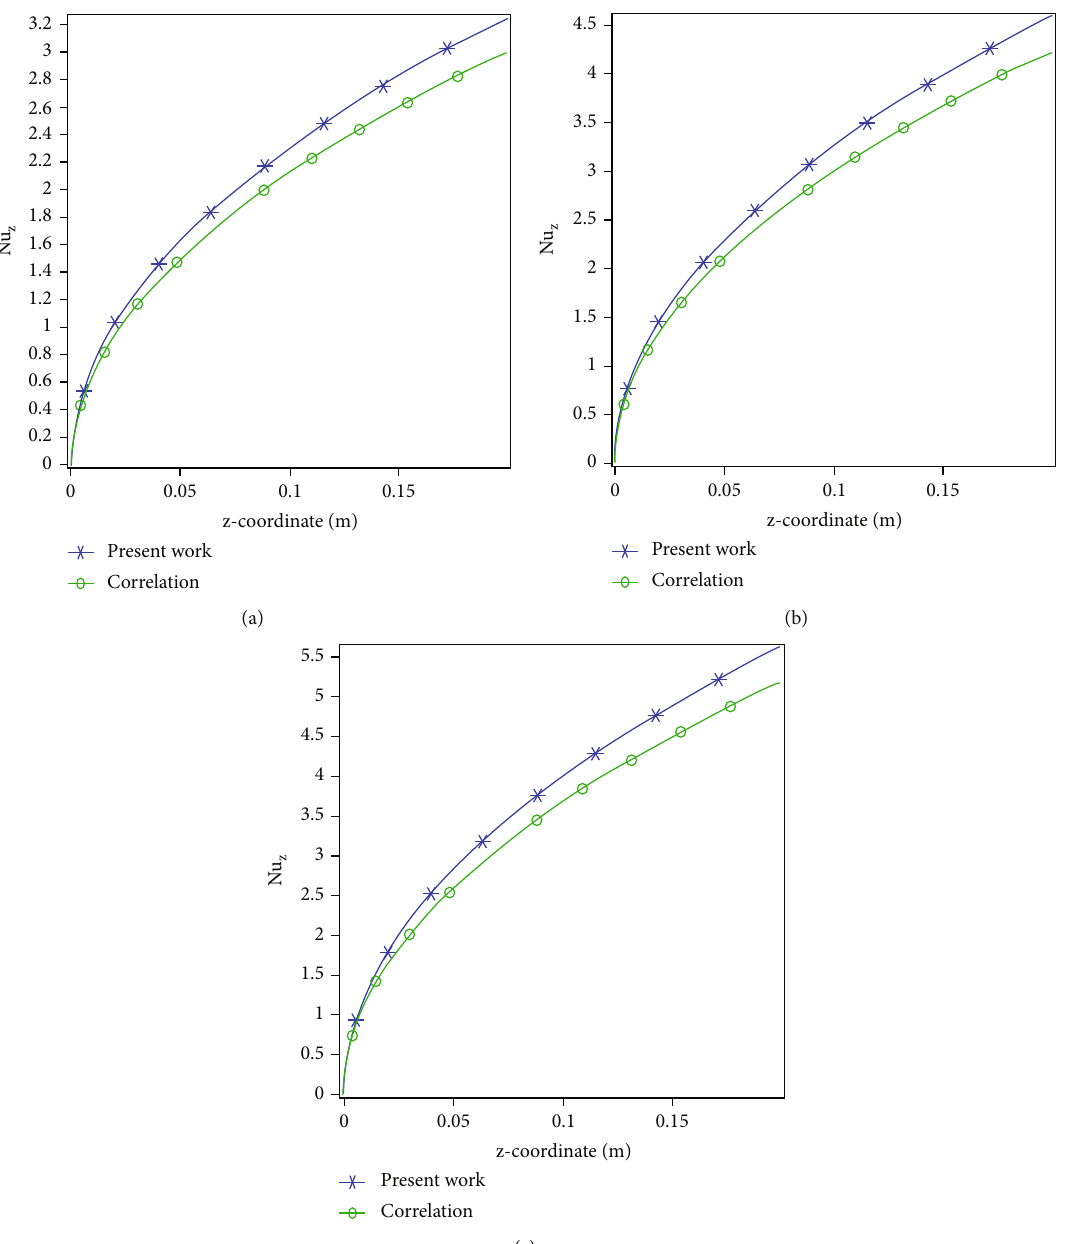
Figure 5: The comparison of the Nusselt number at the vicinity of inlet with the correlation available from the literature at E = 71,000 J/mol: (a) Re = 100 , (b) Re = 200 , and (c) Re = 300